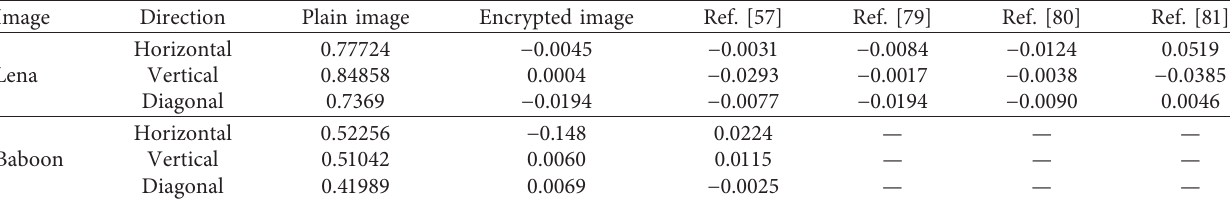
Table 8: Correlation coefficients analysis.